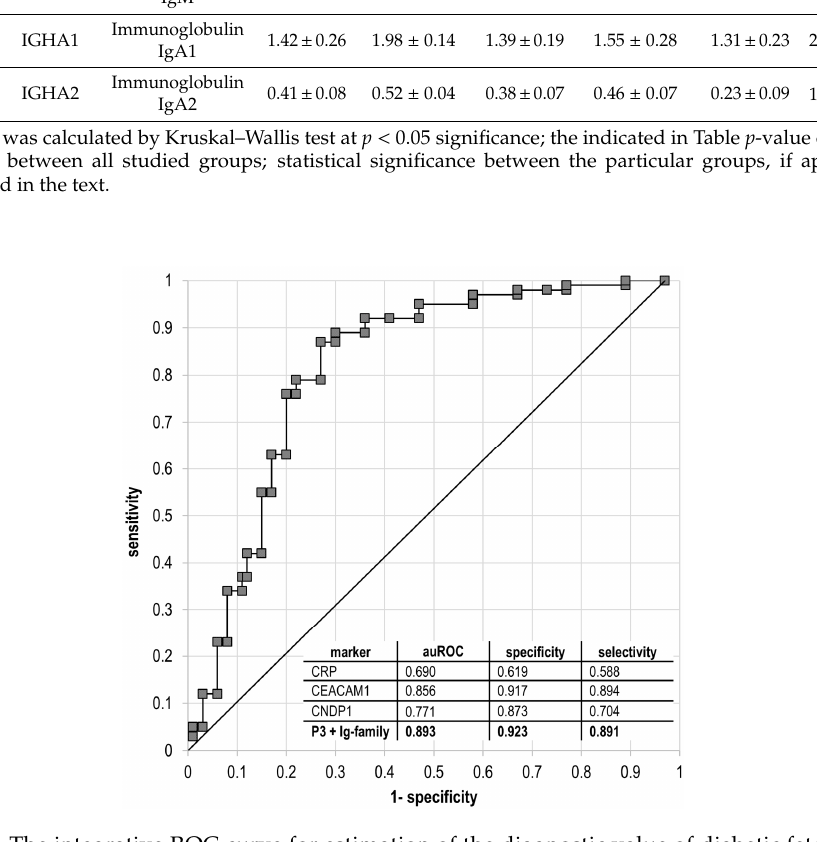
Figure 3. The integrative ROC curve for estimation of the diagnostic value of diabetic fetopathy in patients with T2DM or GDM complicated gestation using CEACAM1, CNDP1, CRP, IgG4 and IgA2 proteins. The integral AUC = 0.893 at 95% CI, 0.785–0.980. The least valuable protein is CRP caused by its highly sensitive fluctuations in response to impairments in many biologic processes (indicated